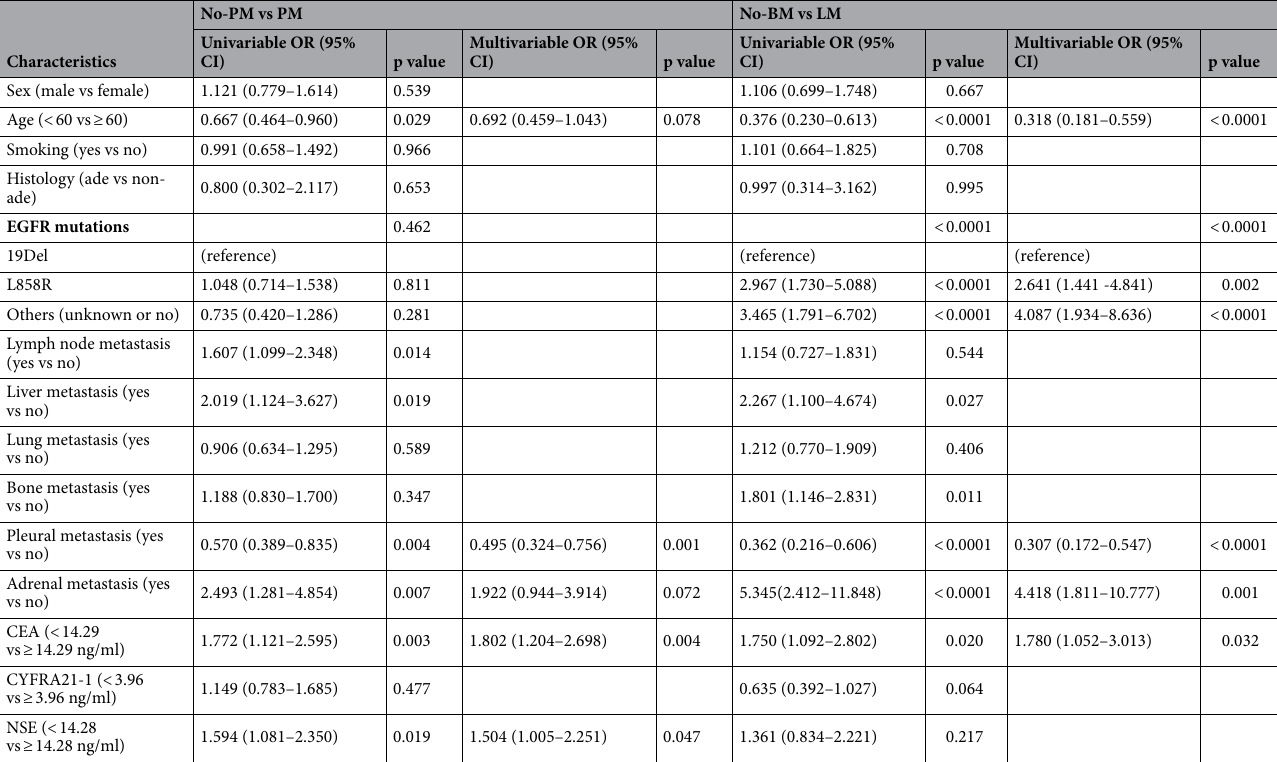
Table 2. Univariate and multivariate logistic analysis of the variables associated with the PM and